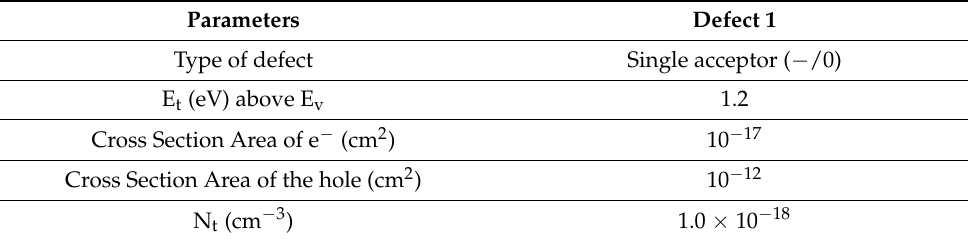
Table 2. The CdS trap state parameters for SCAPS simulation [10,15].